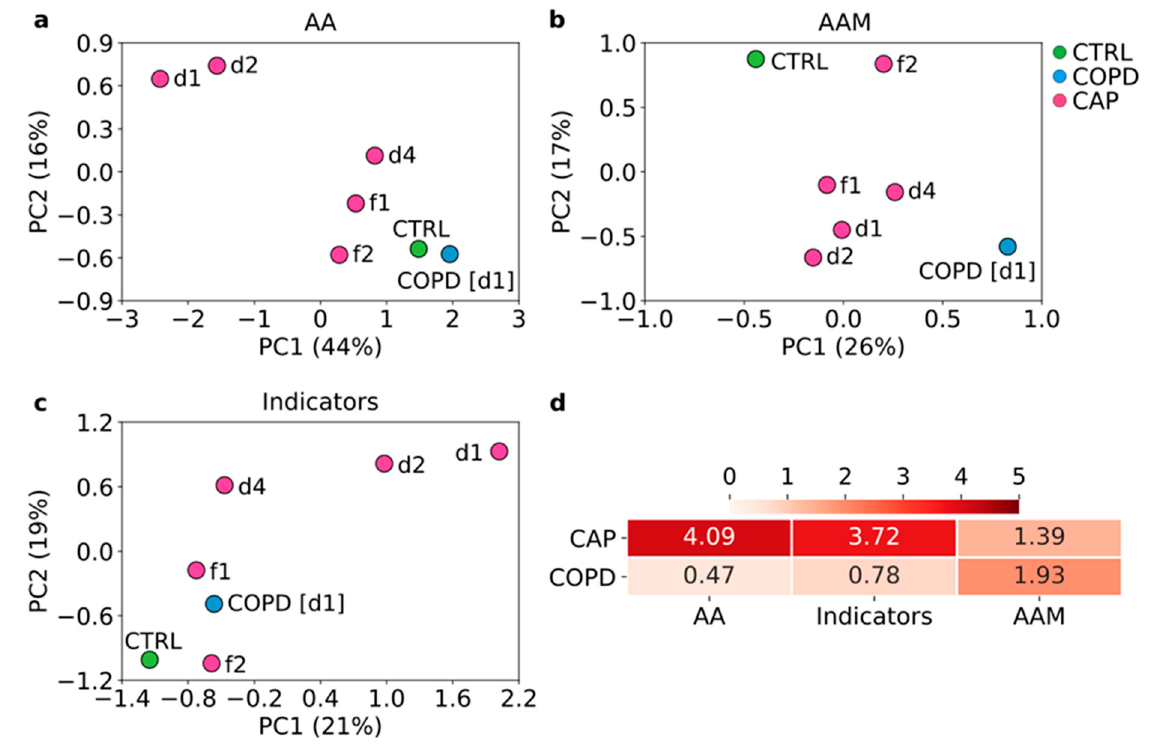
Figure 1. Reprogramming in acid metabolism in acute CAP normalizes with clinical recovery. Principal component analysis (PCA) based either on concentrations of the 20 amino acids or 10 amino acid metabolites that were detected >LOD in at least 75% of all samples ( a , b ) or on the 29 metabolism indicators ( c ). ( d ) Mean Euclidian distances on day 1 between CAP or COPD vs. Controls, based either on amino acids, amino acid metabolites, or metabolism indicators. Reprogramming is greatest in CAP for amino acids and metabolism indicators but is slightly greater in COPD for amino acid metabolites. AA—amino acids; AAM—amino acid metabolites.